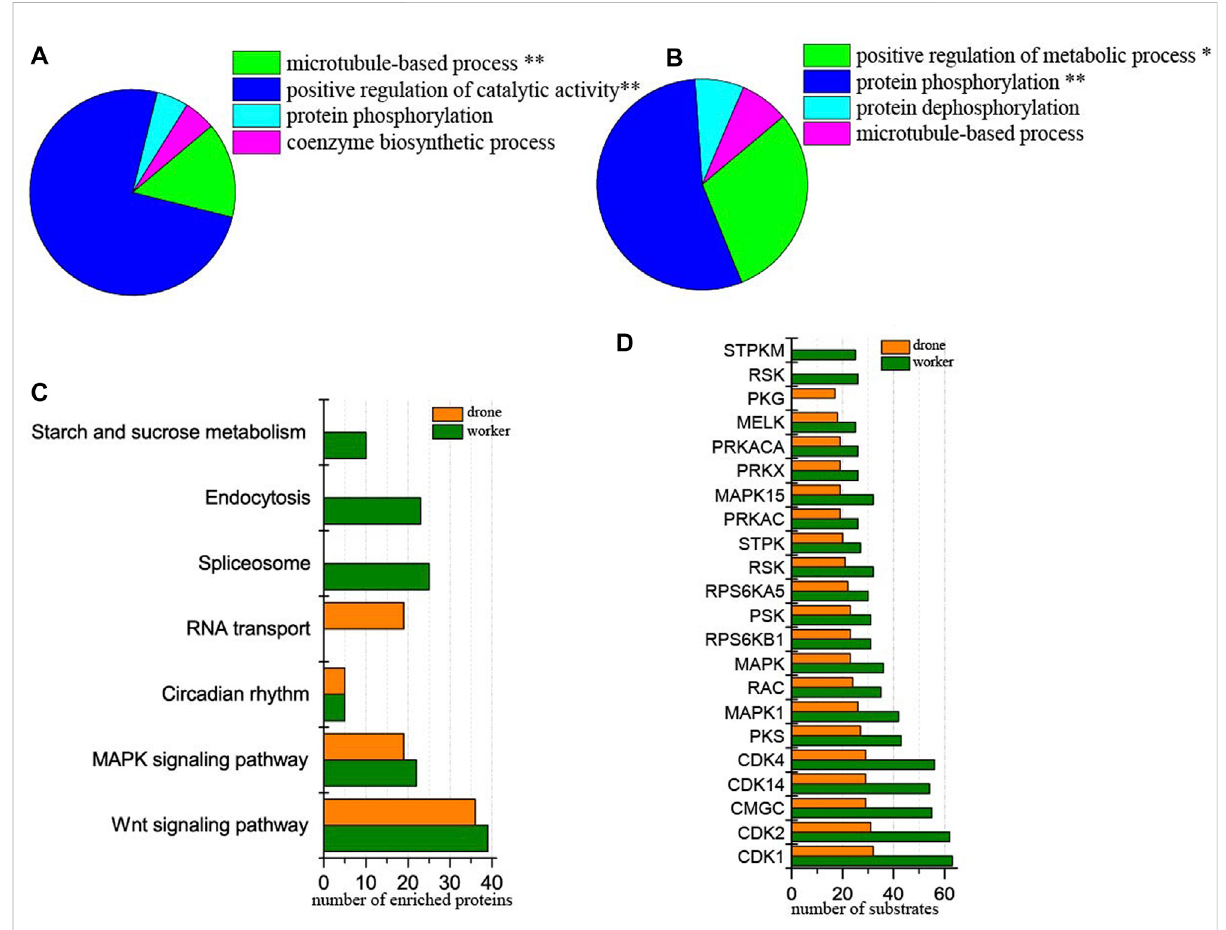
FIGURE 4 Comparison of the phosphoproteins identi fi ed in worker and drone embryo at 24 h. (A) ClueGO analysis of the phosphoproteins identi fi ed in 24 h worker embryos. The signi fi cantly enriched functional GO categories in biological processes were reported by comparing the input data with the background of GO annotations in the honey bee genome, applying a right-sided hyper-geometric test. The nodes in functionally grouped networks were linked based on kappa score (0.4). An FDR was controlled with a Bonferroni step-down test to correct the p -value of GO terms. The single and double asterisks indicate signi fi cant enrichment at p < 0.05 and p < 0.01statistical levels, respectively. (B) ClueGO analysis of the phosphoproteins identi fi ed in 24 h drone embryos. (C) Comparison of the biological pathways enriched in worker and drone embryo at 24 h. (D) Comparison of the kinase activity between the embryogenesis of worker and drone at 24